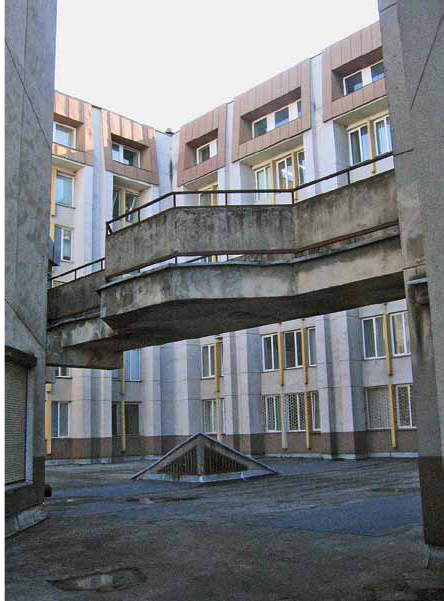
komplekso korpusus. a. novicko nuotr. Fig. 4. View of the courtyard of former Collective Farms‘ Design Institute with the bridge connecting separate units of the complex structure. a. novickas photo